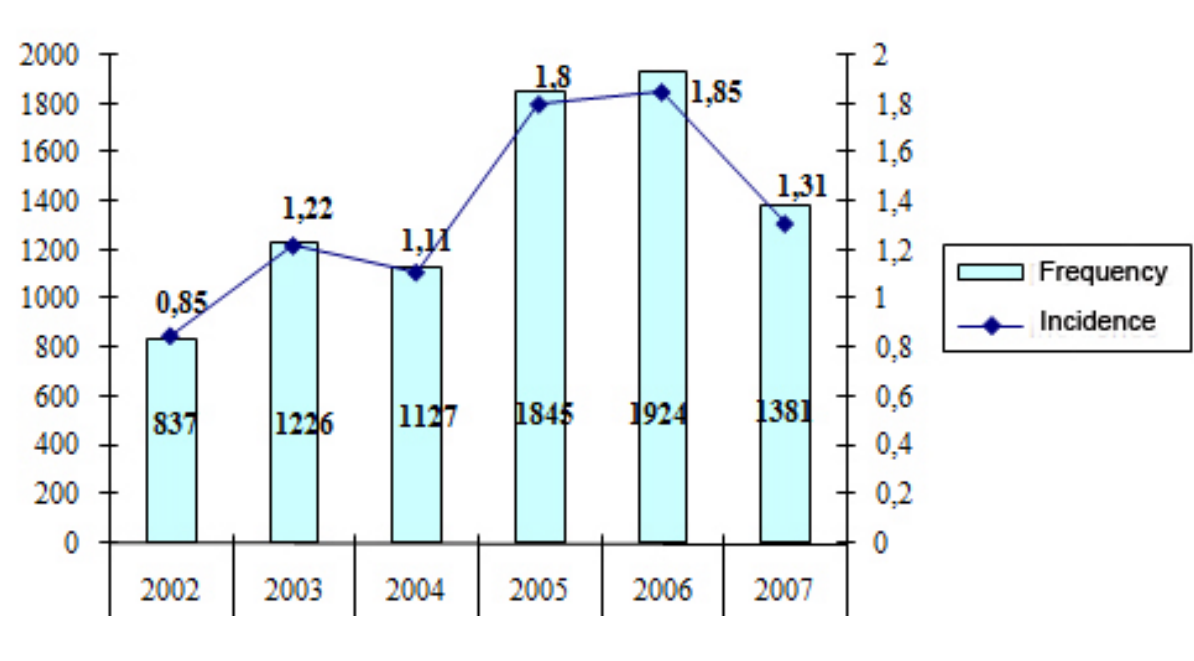
Figure 1. The distribution of scorpion stings by